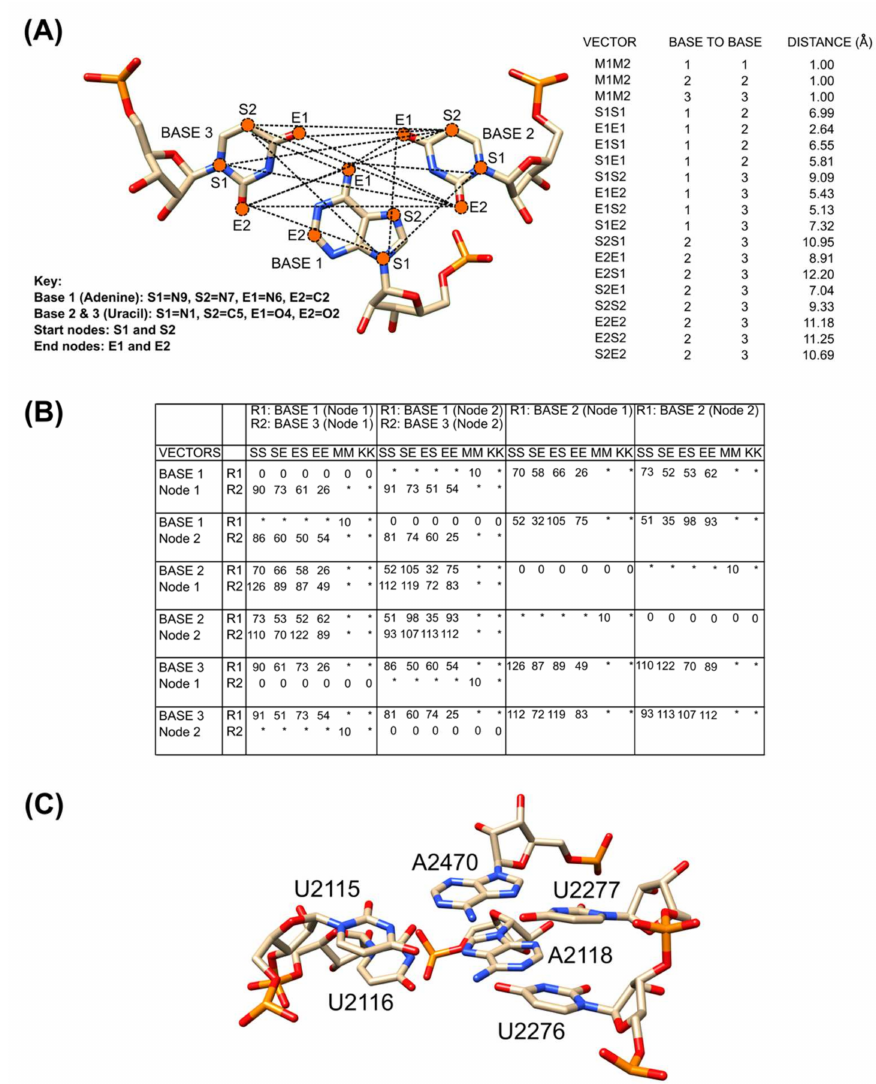
Figure 3. ( A ) The distances between the pseudo-atoms (left panel) that represent the 3D arrangement of the base triple provided are extracted (right panel) and ( B ) converted into matrices to be computed and solved as a sub-graph isomorphism problem. As an example on how to read the matrices (Figure 3B), E1E1 distance between Base 1 and Base 2 that is 2.64 Å (right panel of Figure 3A) is marked as 26 (distance × 10) under the EE column of Base 1 (Node 1) and the R1 row of Base 2 (Node 1) in the matrices. The distance of 0 Å is for the instances where the nodes map into itself and * is for the instances where the distance is undefined. ( C ) A-stacked UAU base triple found in domain V of the 23S subunit of prokaryotic